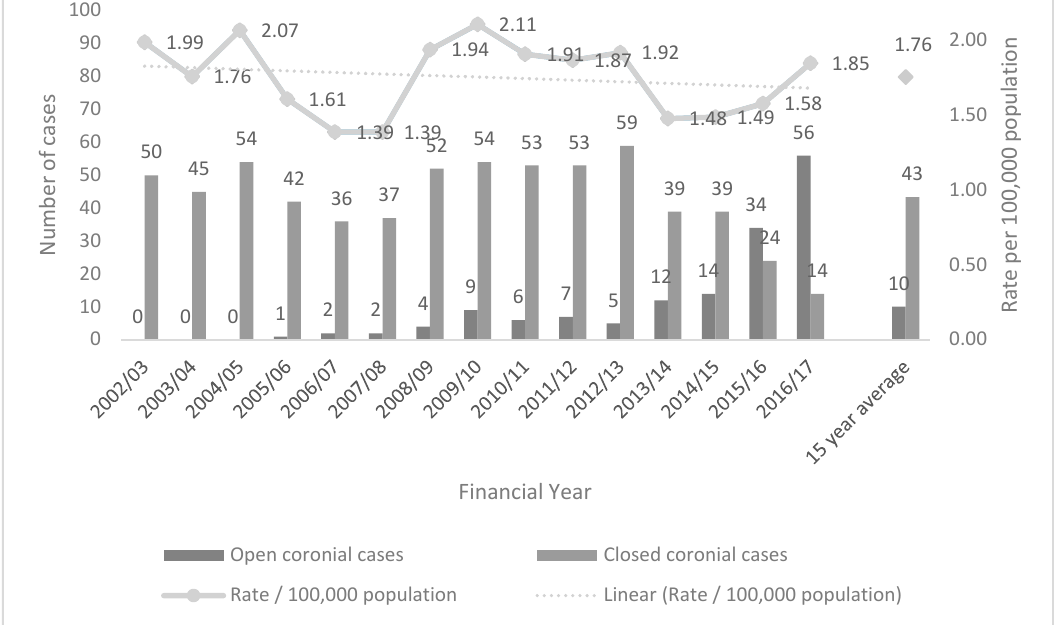
Figure 1. Unintentional fatal drowning incidence and rate among people aged 65 years and over in Australia by status within National Coronial Information System (NCIS), 15-year average, Australia (N = 803).